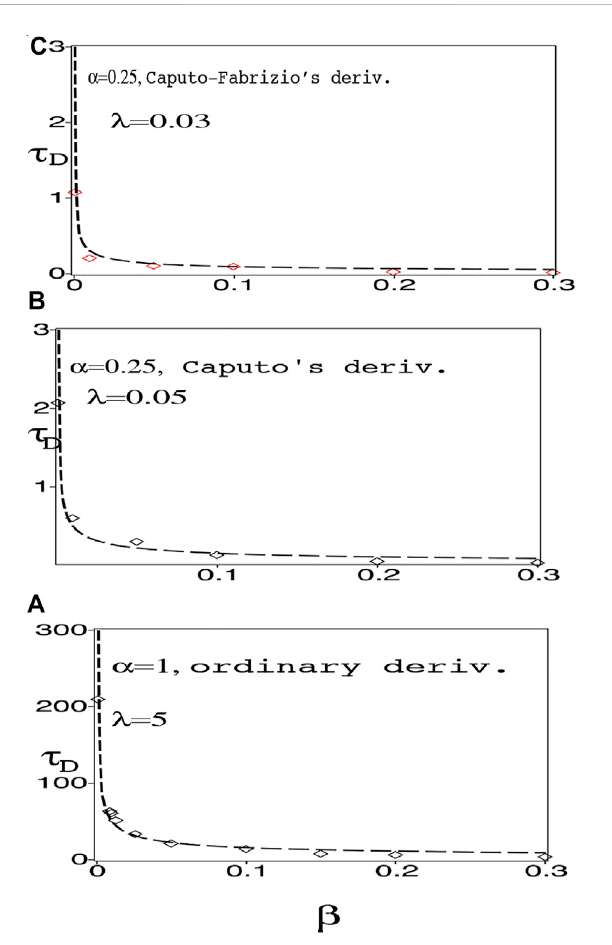
FIGURE 6 Time-delay, τ D , versus the perturbation parameter β at the switching-on point A on in Figure 1. Circles represent the numerical results and the dashed lines represent the corresponding fi ttings, λ / (A) The case of ordinary derivative ( α =1). (B) The case of Caputo ’ s fractional derivative ( α =0.25). (C) As (B) but with Caputo-Fabrizio ’ s fractional derivative.